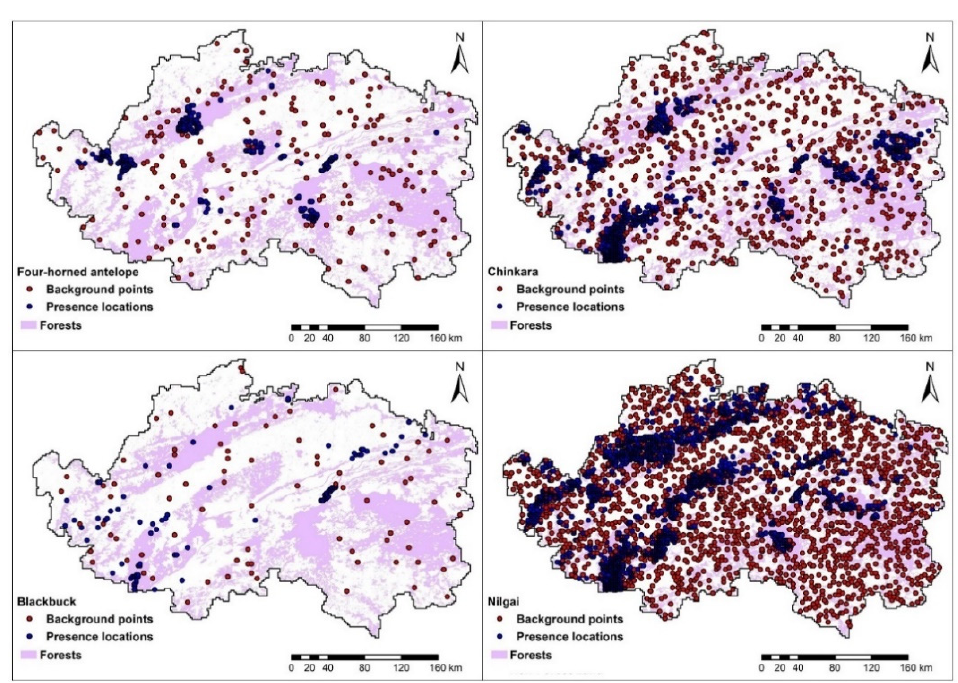
Figure 3. Species presence data and equal number of simulated background points used for suitability